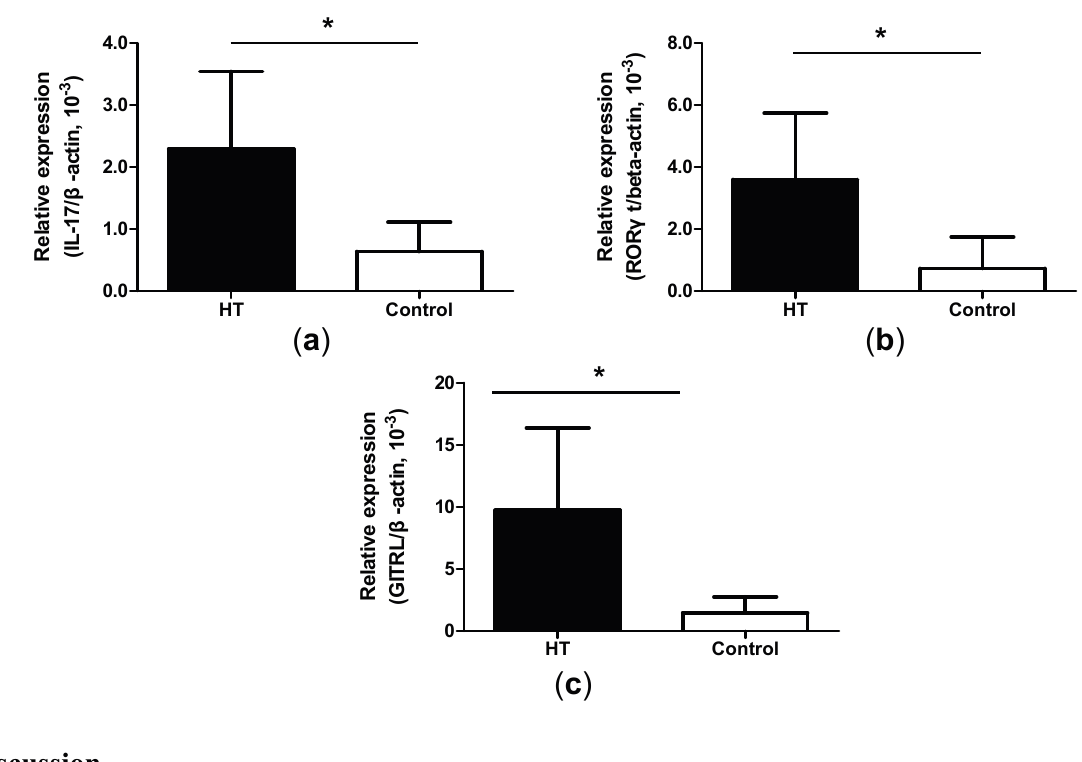
Figure 5. Higher expression of IL-17, ROR- γ t and GITRL mRNA in thyroid tissue from HT patients. ( a ) The levels of IL-17 mRNA in thyroid glands were detected by real-time PCR from HT patients, and patients with simple goiter; ( b ) The levels of ROR- γ t mRNA in thyroid glands were detected by real-time PCR from HT patients, and patients with simple goiter and ( c ) The levels of GITRL mRNA in thyroid glands were detected by real-time PCR from HT patients, and patients with simple goiter. * p <